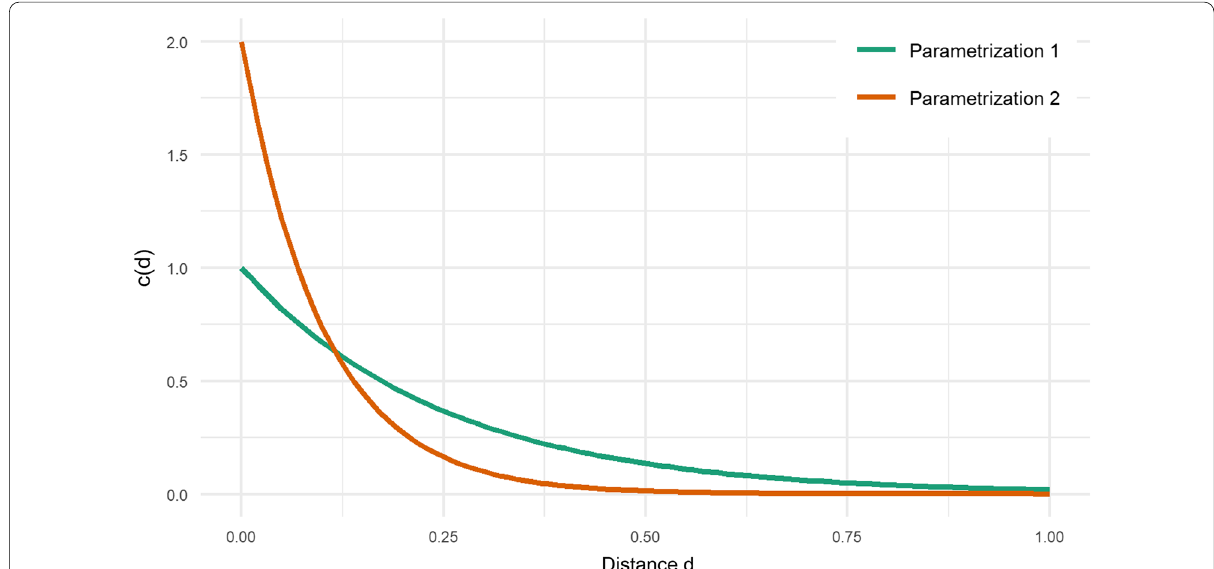
Fig. 2 Covariance functions. Two exponential covariance functions which are depending on a distance d and parametrized as given in Table 1. One can clearly see that the variance in Parametrization 1 is lower than in Parametrization 2. On the other hand, Parametrization 1 has a greater range which leads to slower decay of the covariance function over distance